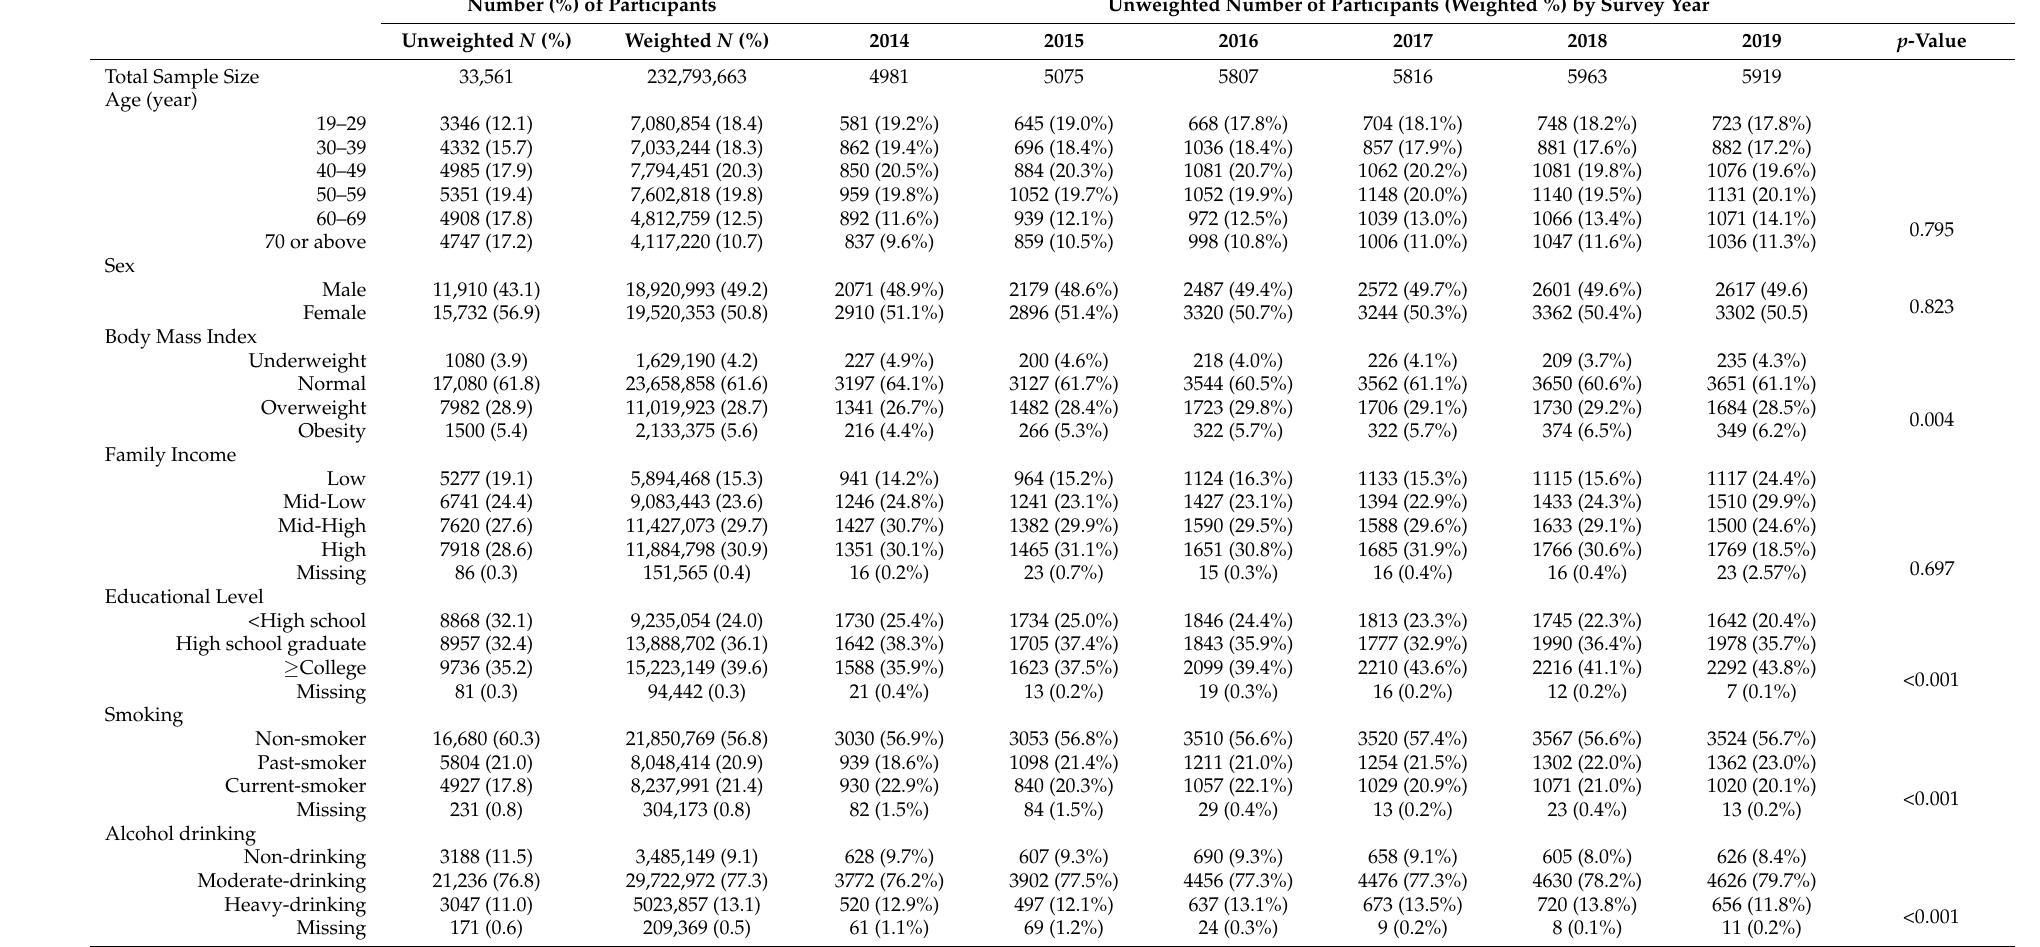
Table 1. Characteristics of participants by survey